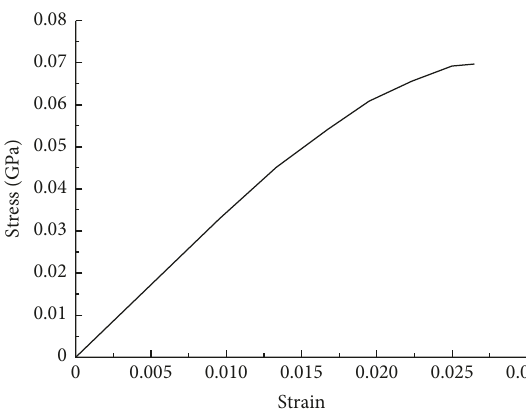
Figure 9: Stress-strain curve of the polylactic acid.